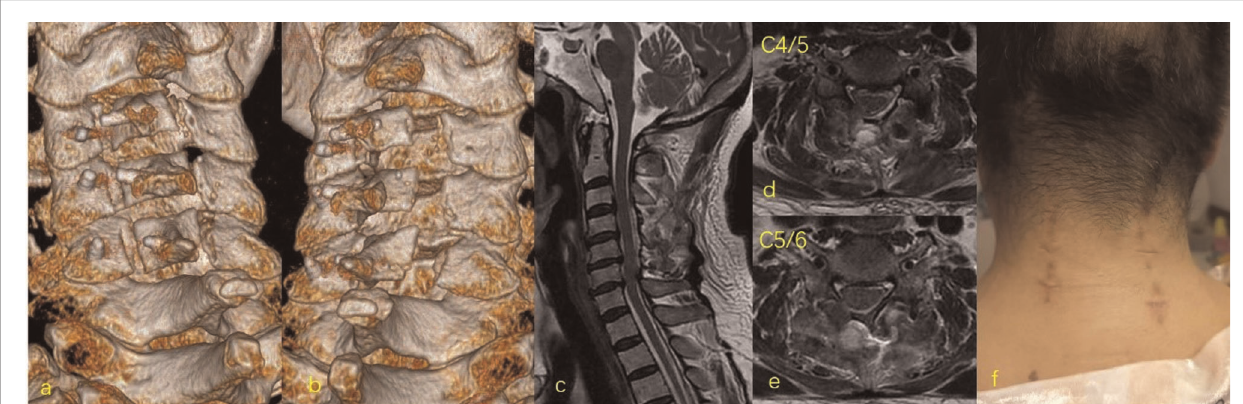
FIGURE 5 | Postoperative 3D CT of C4-C6 showed widening of the spinal canal after BBE laminoplasty using suture anchor fi xation ( A , B ) Postoperative MRI showed full decompression of spinal cord with an adequate subarachnoid space ( C – E ). Six wounds were created for the cervical laminoplasty at three levels ( F ).